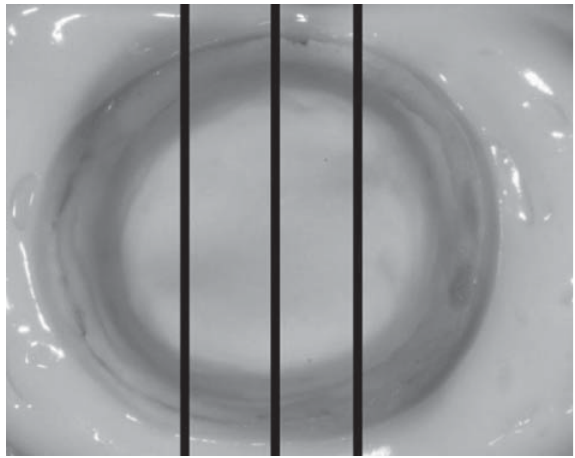
Figure 2 - Occlusal view of the silicone layer on the replica tooth resin prior to embedding with heavy body silicone. The lines indicate the zones where the silicone will be sectioned